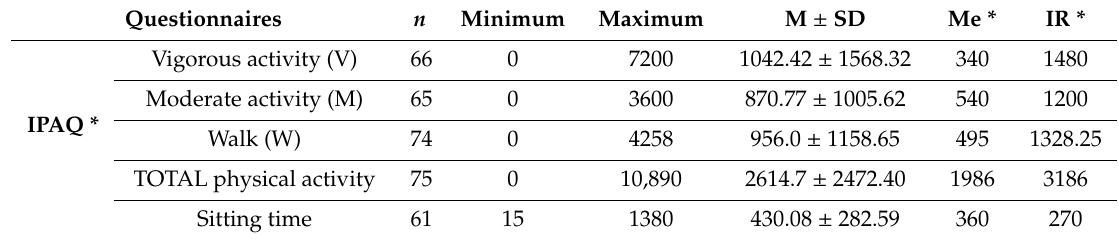
Table 3. Descriptive statistics of physical activity in minutes per